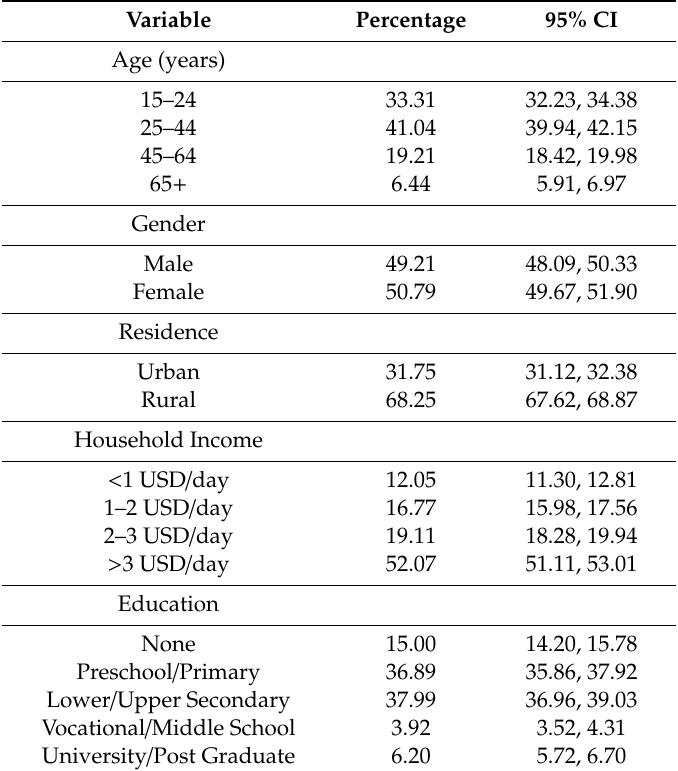
Table 1. Demographic characteristics of the 9043 adults (ages 15 and older) of the 2012 National Adult Tobacco Survey of Lao